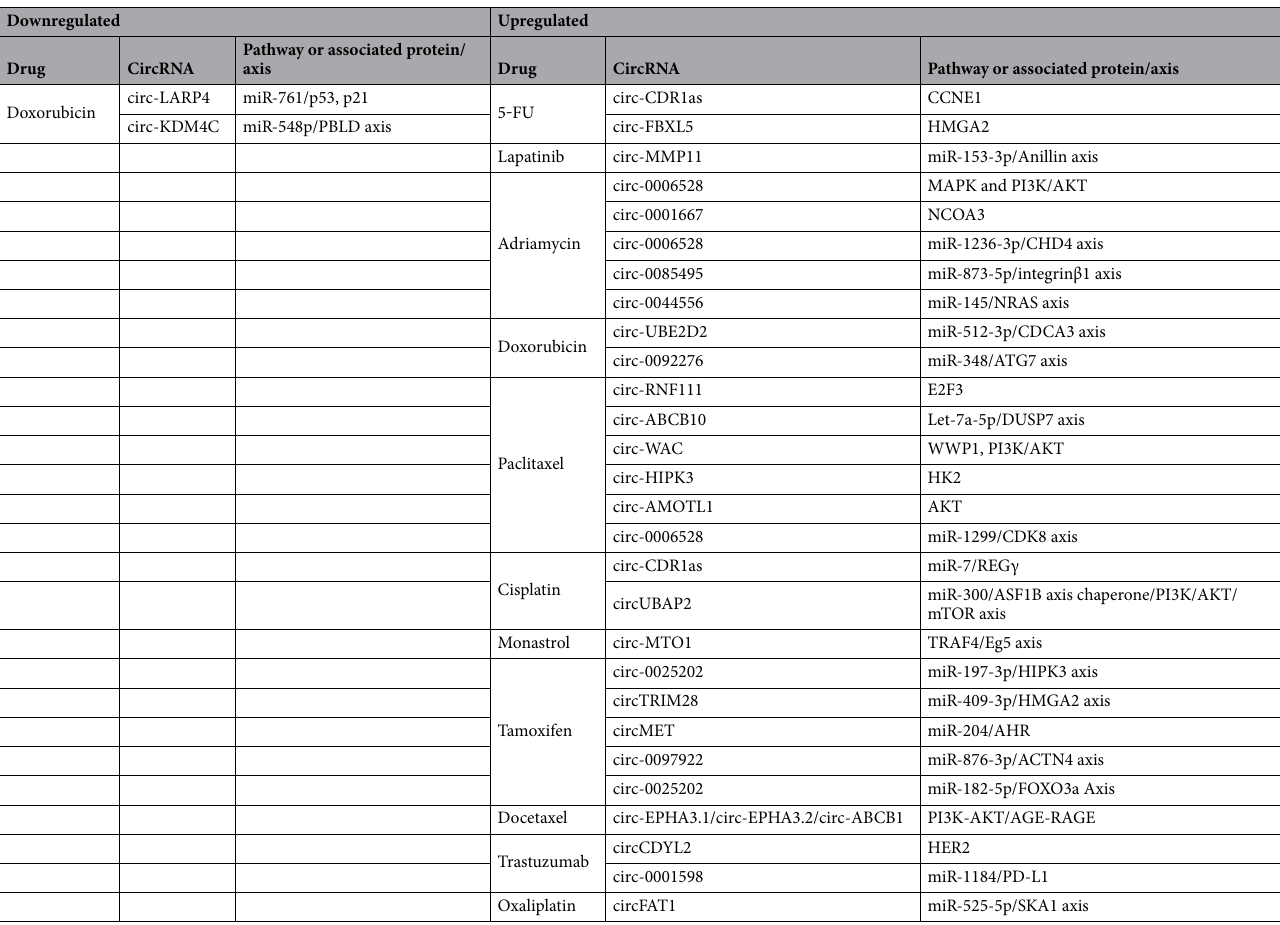
Table 1. Genetic pathways, proteins or axes involved in BC drug